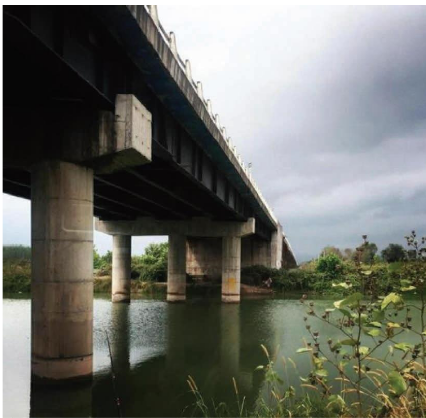
Figure 1: Concrete columns with a circular cross section in Guilan province in northern